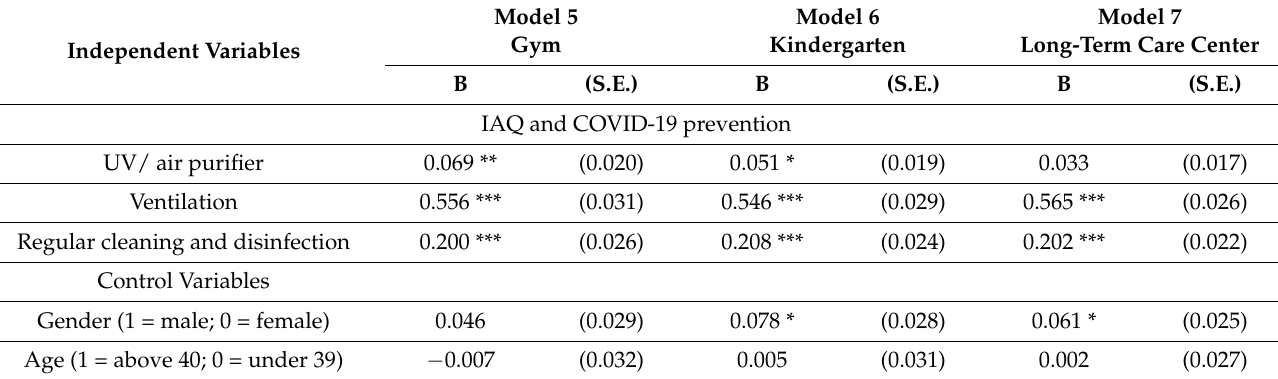
Table 9. The IAQ and COVID-19 prevention regression (three